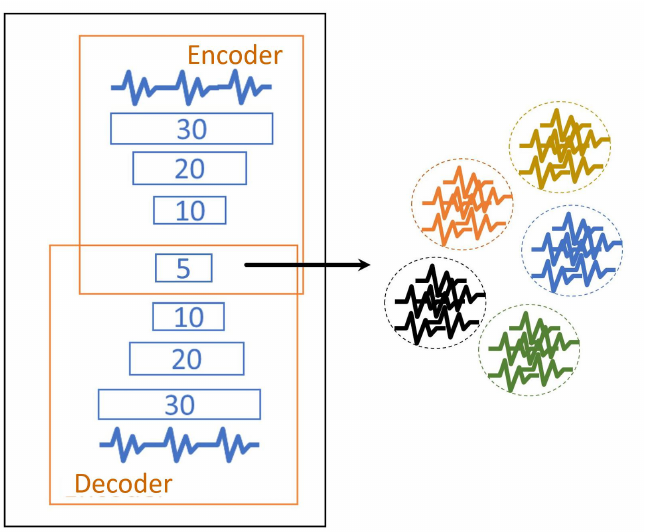
Figure 3. The DAE network architecture for time-series data shown the number of neurons for each fully-connected layer in both encoder and decoder